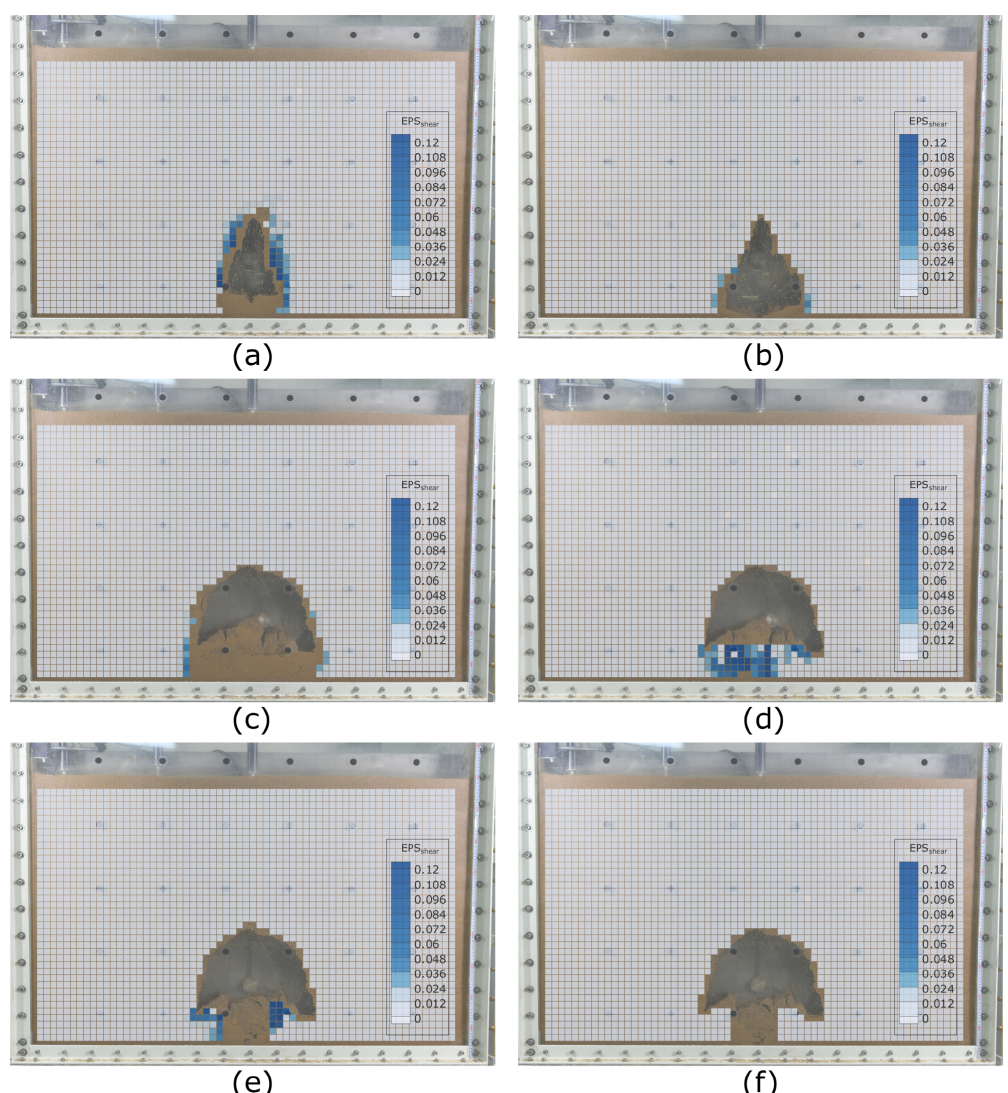
Figure 6. Shear strain inside the model ground for Test 1 during the water drainage stage: (a) 0–30s, (b) 30–60s, (c) 60–90s, (d) 90–120s, (e) 120–150s, and (f)